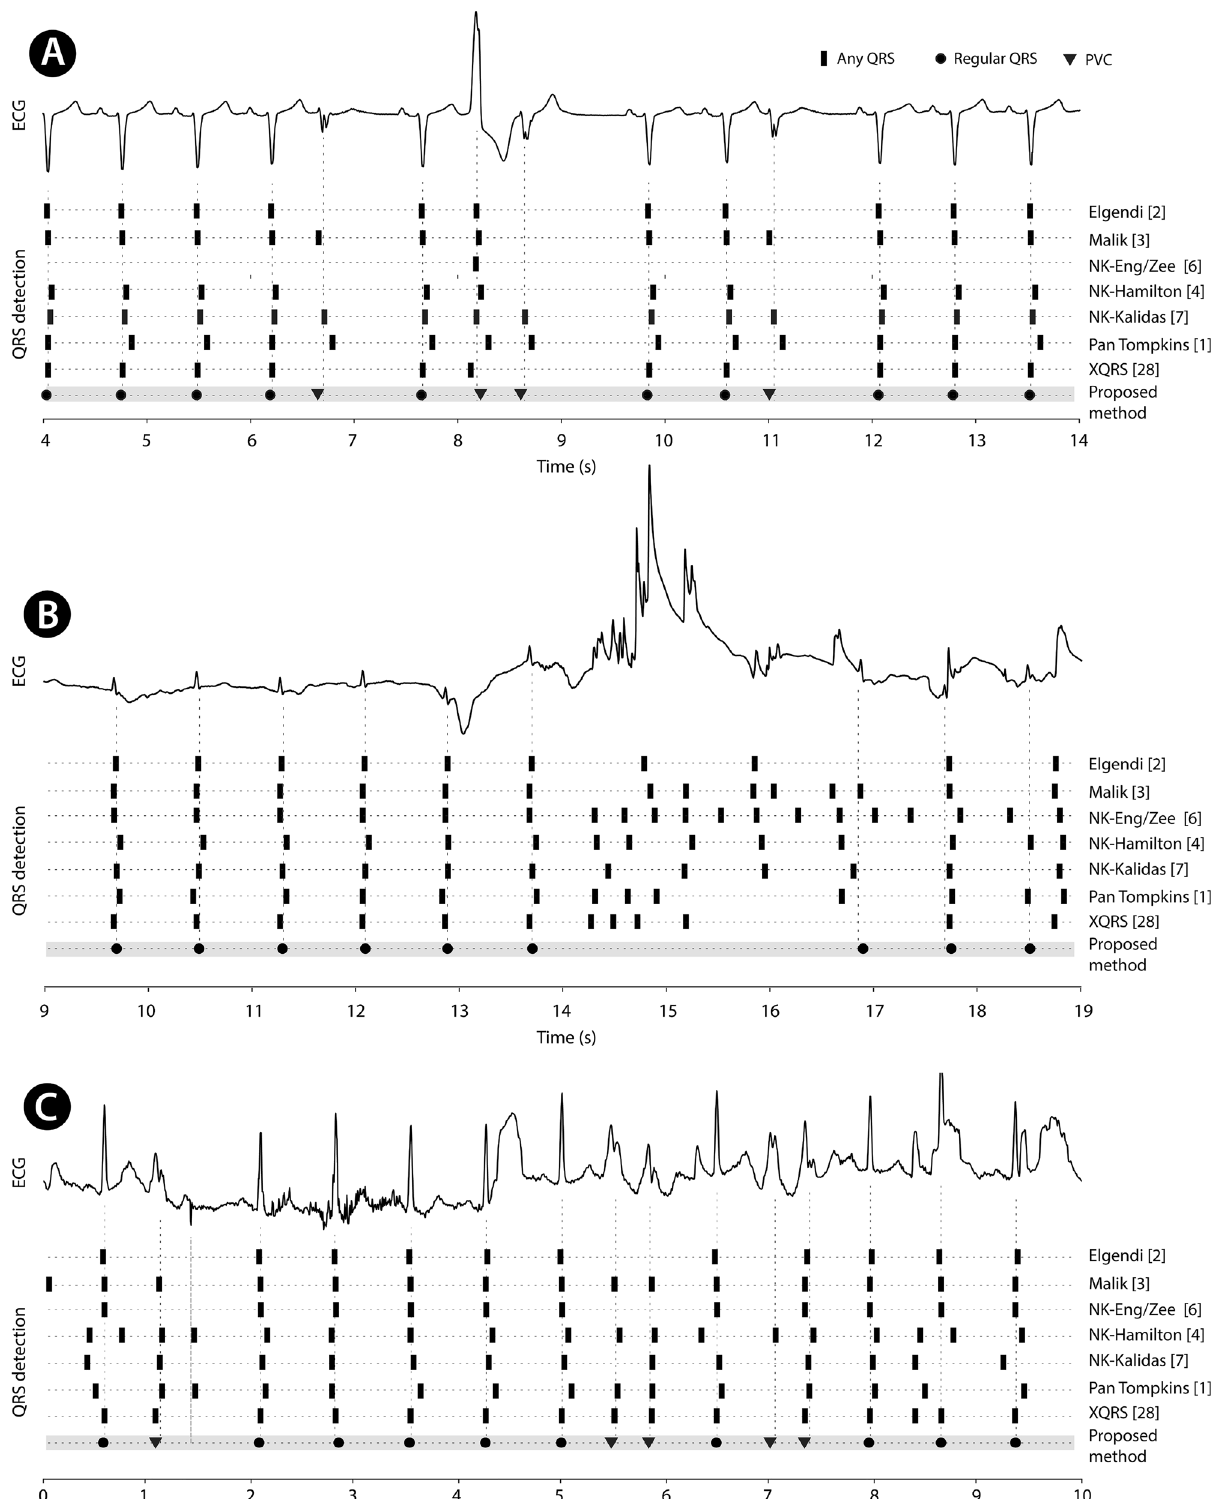
Figure 6. Non-trivial Holter ECG examples (parts of 30-s blocks) with QRS detection results by several methods. ( A ) Normal sinus rhythm with multifocal premature ventricular beats; ( B ) normal sinus rhythm, heavily disturbed; ( C ) normal sinus rhythm, disturbed, with premature ventricular beats. Bold black rectangles refer to regular QRS, filled triangles refer to premature ventricular contraction (PVC). Bold vertical at approx. second 1.3 refers to a questionable PVC combined with an artifact. Shown signals were not used for development nor testing of the presented